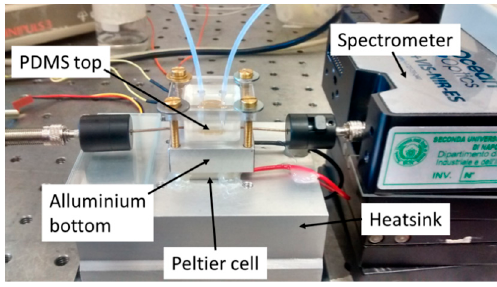
Figure 3. Picture of the experimental setup.